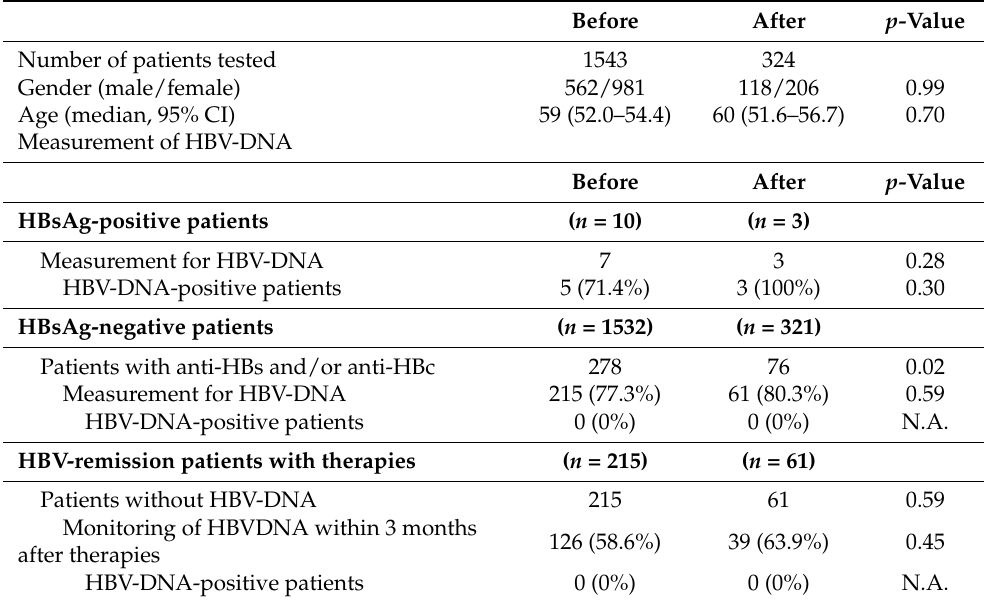
Table 5. Measurement rates of HBV-DNA in patients who received other immunosuppressive therapies before and after the introduction of the alert